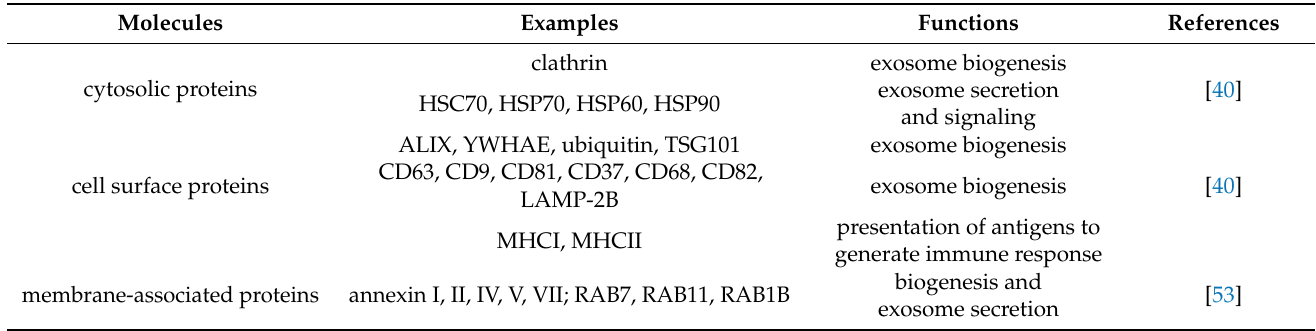
Table 1. Exosomal molecular